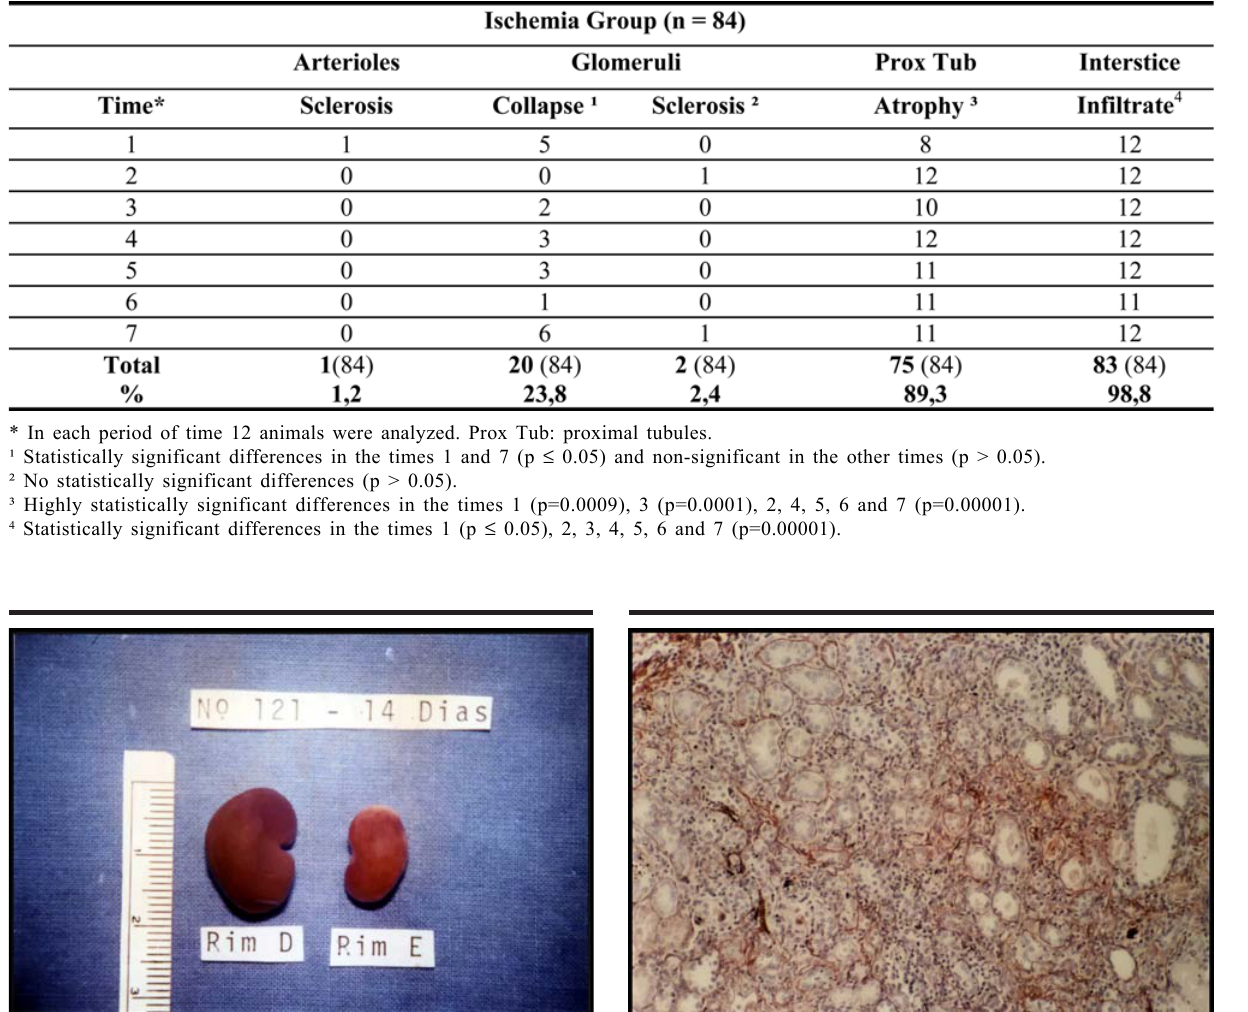
TABLE 2 - Results of the histological findings for glomerular, proximal tubular and interstitial alterations in the ischemia group